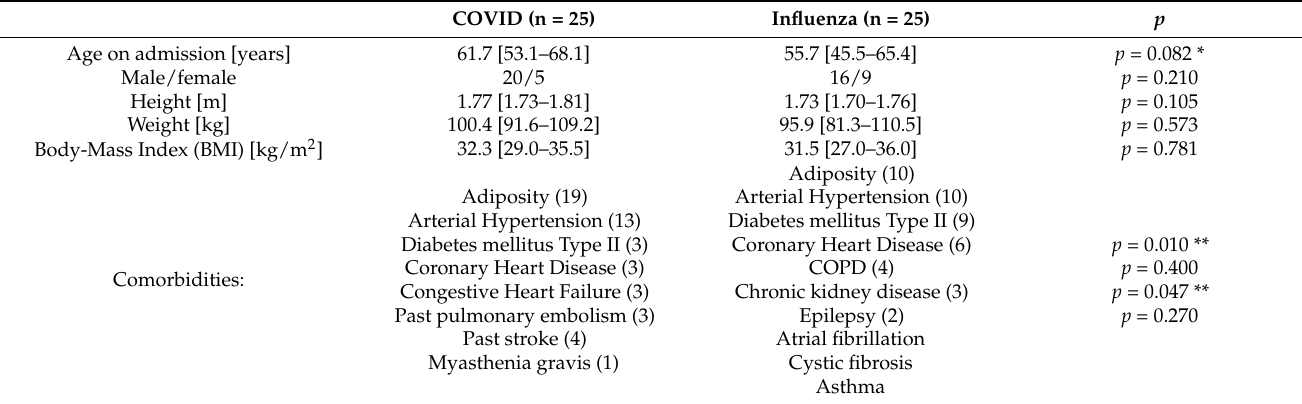
Table 1. Basic patient